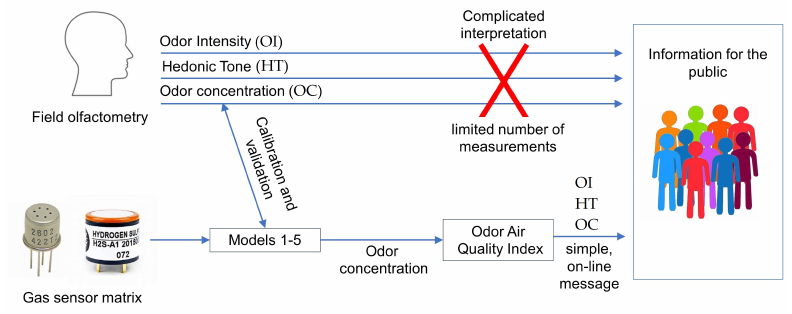
Figure 2. The concept of the conducted